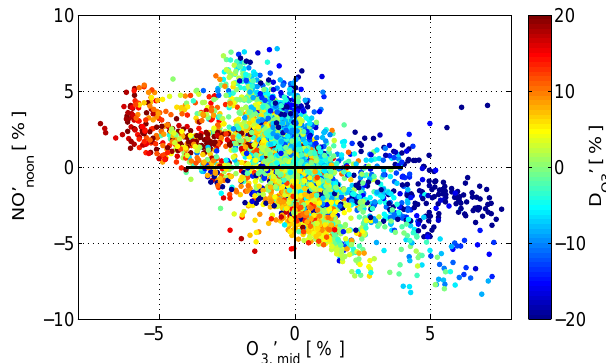
Figure 13. Dependence of D O anomalies on anomalies in NO noon 3 (NO at 12:00LT) and O 3 , mid (O 3 at 24:00LT) for monthly means of March, June, September and December. Data points are taken from λ sub ± 30 ◦ , where λ sub is the subsolar latitude. Two anti-correlations appear: increased (decreased) NO noon or O 3 , mid mostly lead to decreasing (increasing) D O 3